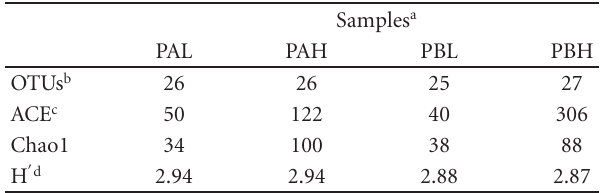
Table 1: Species richness estimates and diversity of 16S rRNA gene clones calculated by